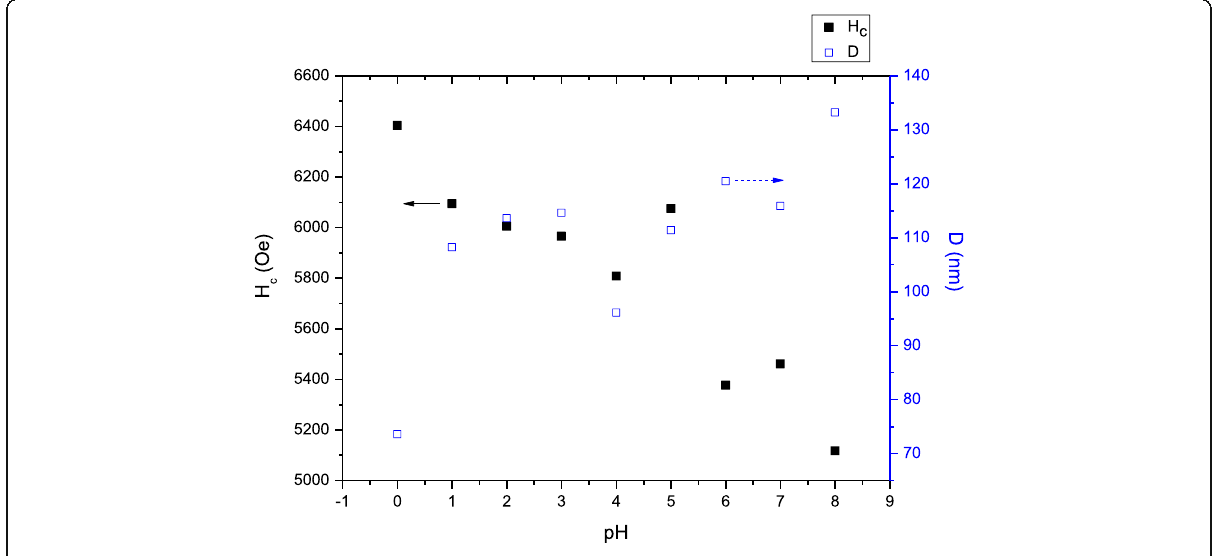
Fig. 10 Relation of H c and grain size of SrFe 12 O 19 at varied pH sintered at 900